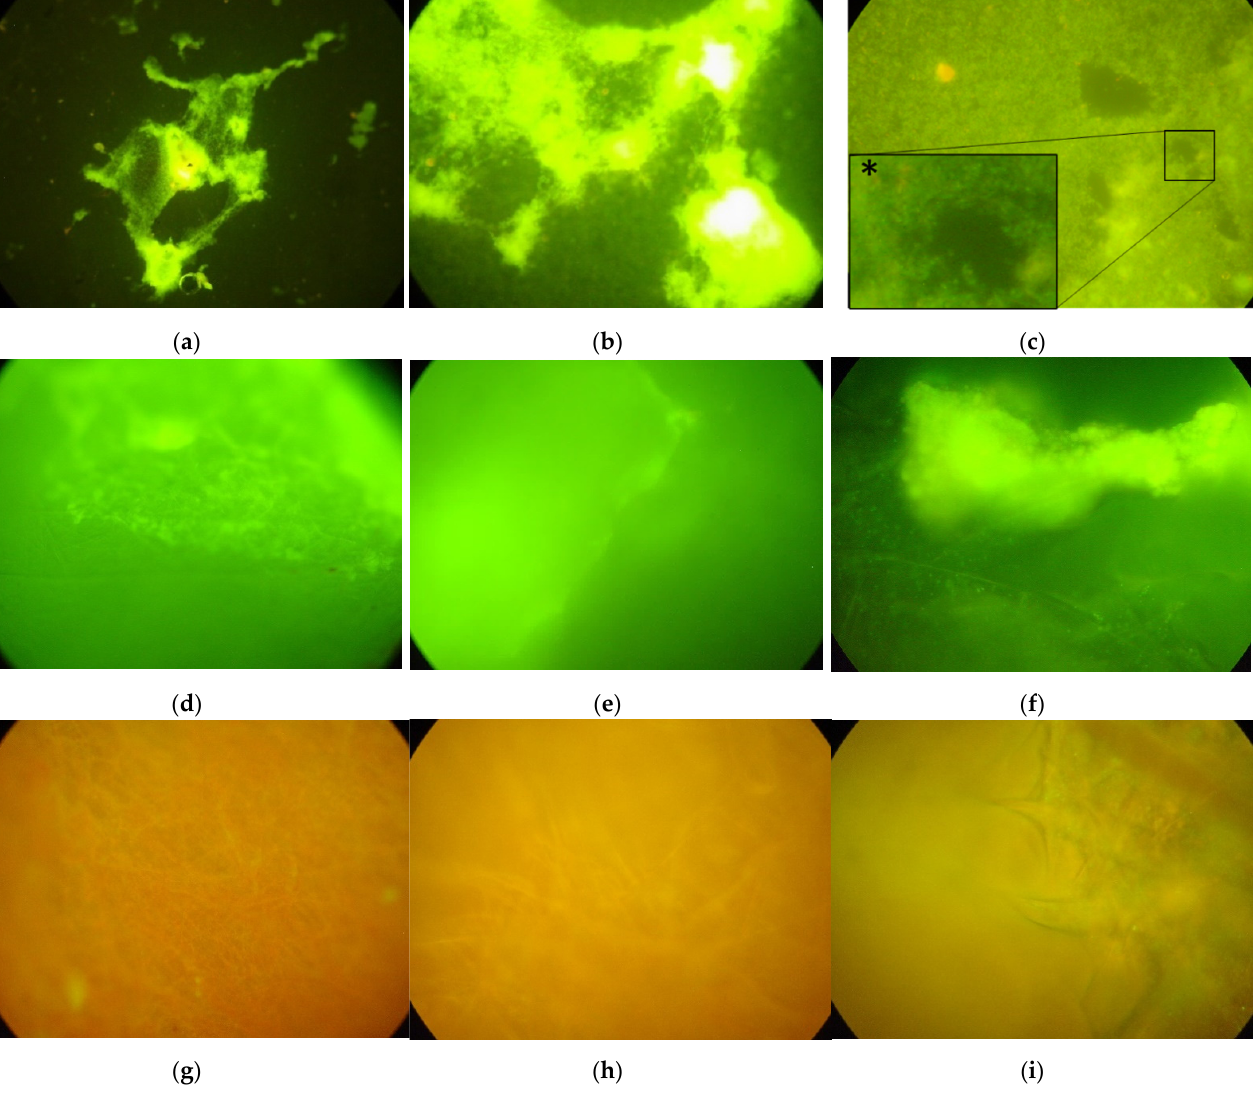
Figure 4. Biofilm of Legionella pneumophila SG 2–16 at 10×, 40× and 100× of microscope magnification formed without coupon ( a – c ), on floating PP coupons ( d – f ) and on floating s-PBC@PP coupons ( g – i ), respectively. Detail of cell bodies at 100× magnification ( * ).